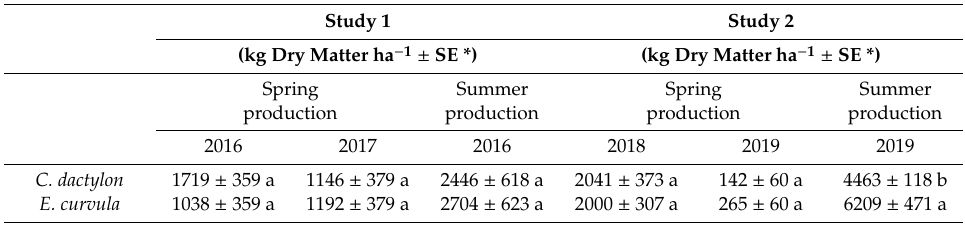
Table 1. Cynodon dactylon and Eragrostis curvula biomass (kg dry matter ha − 1 ) under pasture cropping